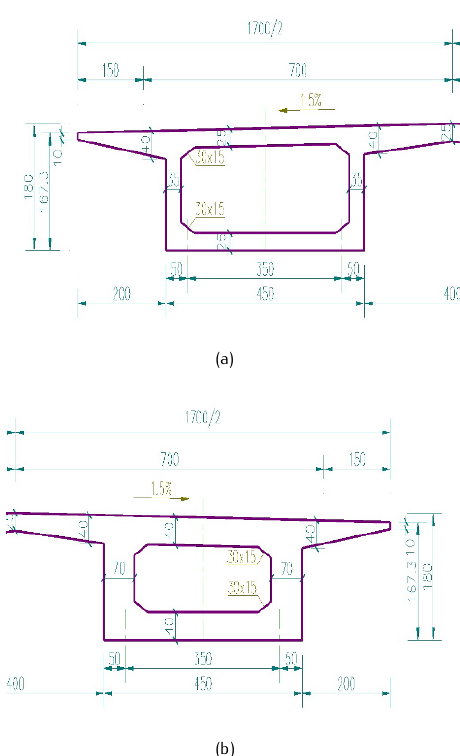
Figure 2. The layout of transverse section of the bridge. (a) half section of mid-span box girder, (b) half section of pier box girder (dimension in